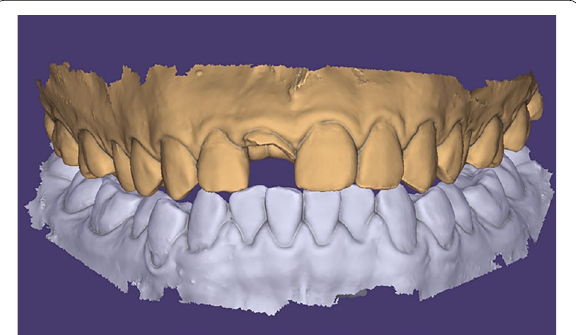
Fig. 2 Scan data of maxillary and